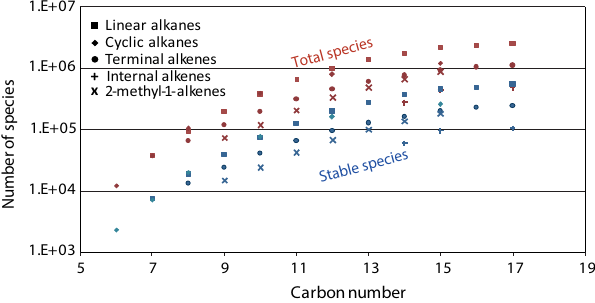
Figure 4. Number of stable (blue) and total organic species (red) in the reduced chemical schemes generated with GECKO-A as a function of the number of carbons in the parent compound for the studied precursor’s